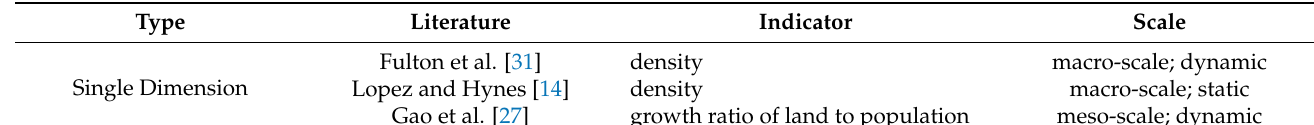
Table 1. Types of urban sprawl measurements in the